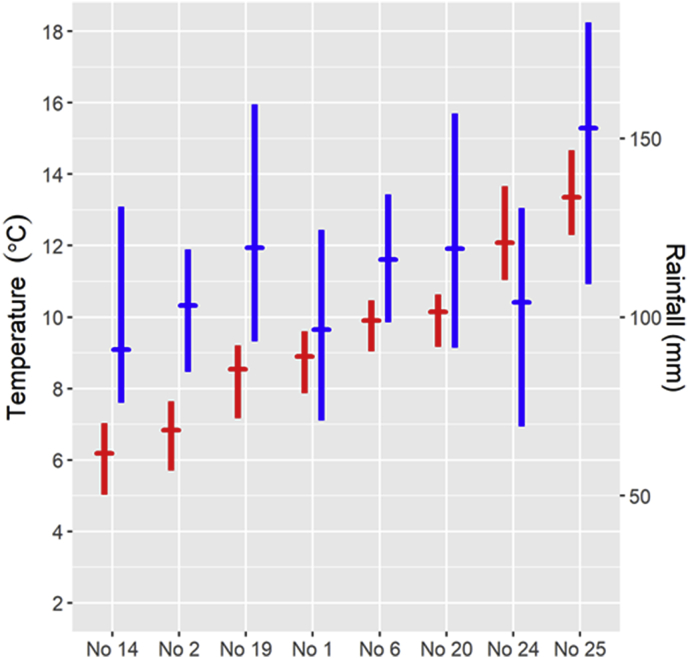
Calculated mean temperature (°C) and monthly rainfall (mm) for June–August at the average altitude of the main summer pasture areas for eight wild reindeer and red deer populations sampled for parasitological studies 2012–2014. The data represent the five summers prior to sampling. The range and average (horizontal bar) of mean monthly temperature (left y-axis) and rainfall (right y-axis) are shown by red and blue lines respectively. Reindeer populations (No): 14 Nordfjella, 2 Snøhetta, 19 Setesdal Ryfylke, 1 Forollhogna, 6 Rondane, 20 Setesdal Austhei. Red deer populations (No): 24 Ørsta, 25 Kvinnherad. (For interpretation of the references to color in this figure legend, the reader is referred to the Web version of this article.)